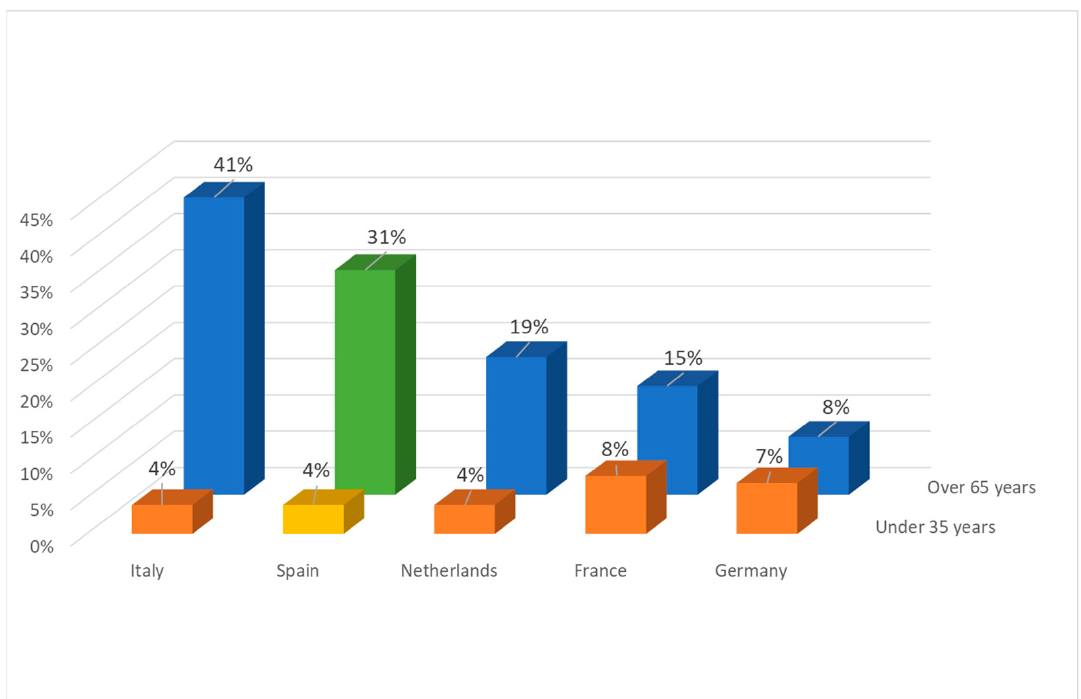
Figure 9. Distribution of farms by age range of the owners in European countries with relevant agricultural activity (2016) [16].